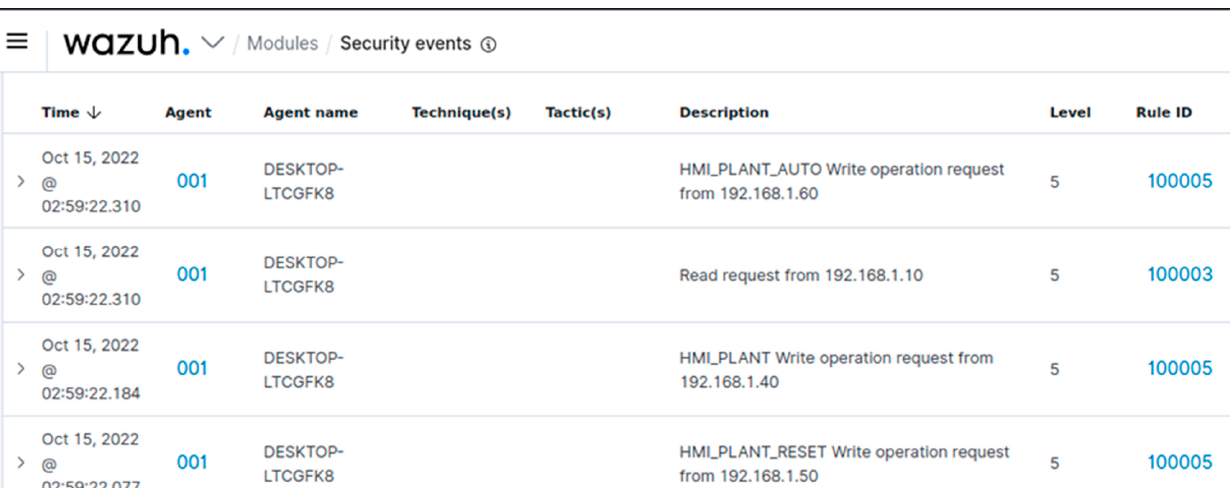
Figure 19. Graphical Representation of Alerts in Wazuh. The alert summary can be downloaded from the server where all the alerts are stored. Figure 20 is the example of such summary generated at the time of model testing.